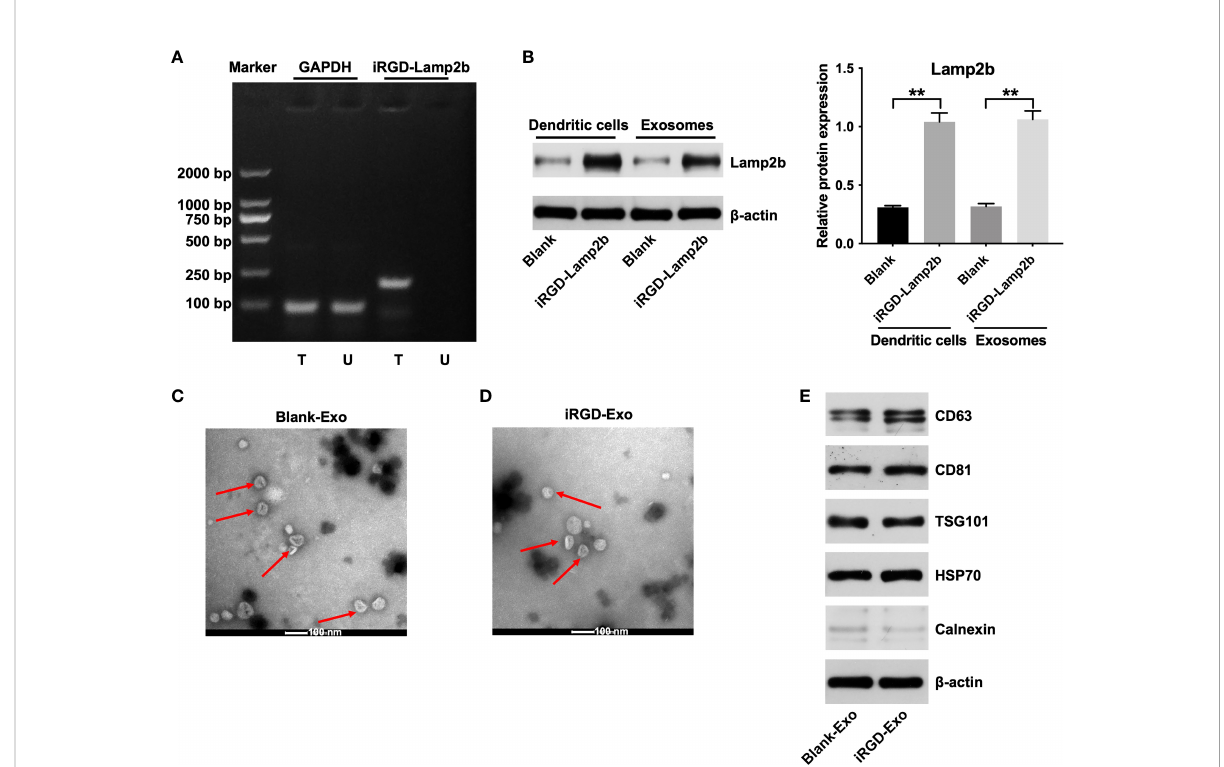
FIGURE 2 Isolation and characterization of iRGD-Exo. (A) DCs were untransfected (U) or transfected (T) with iRGD-Lamp2b plasmids, and the RT-PCR products were detected using agarose gel electrophoresis. (B) Western blot analysis of Lamp2b expression in transfected with DCs and its derived exosomes. **P < 0.01. (C, D) Identi fi cation of exosomes derived from DCs (blank-Exos) and DCs transfected with iRGD-Lamp2b plasmids (iRGD-Exos) by TEM. Scale bar, 100 nm; Red arrow: exosomes. (E) Western blot analysis of CD63, CD81, TSG101, HSP70 and calnexin expressions in Blank-Exo and